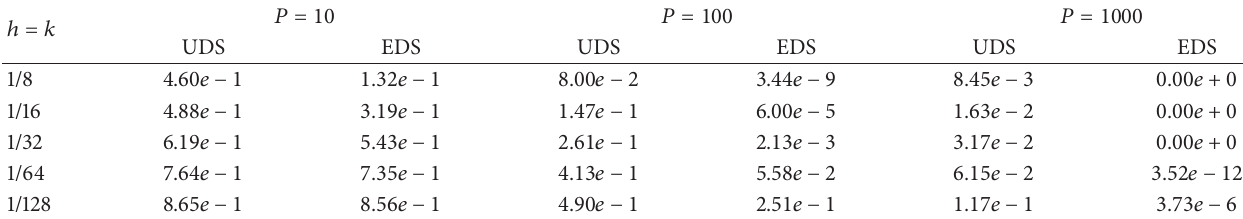
Table 6: Maximum absolute errors in the computed solution of Example 9.